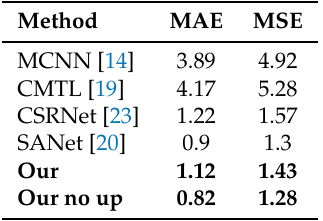
Table 6. Subway cars dataset performance